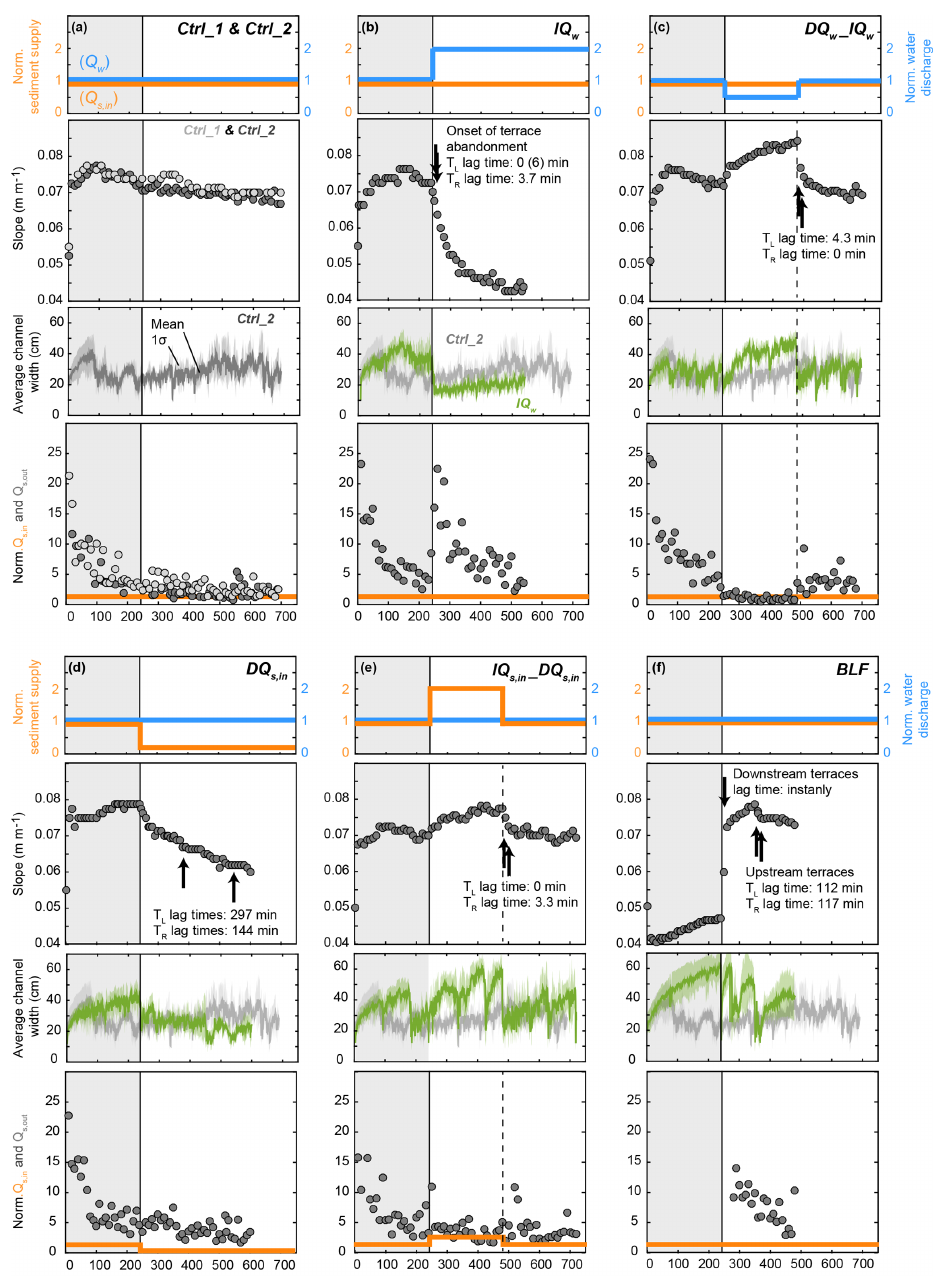
Figure 6. Input parameters and evolution of channel slope, channel width, and Q s , out during the experiments. Input sediment ( Q s , in , orange solid line) and water discharge ( Q w , blue solid line) were normalized to the reference input values ( Q s , ref = 1 . 3mLs − 1 and Q w , ref = 95mLs − 1 ). Slope ( S , grey circles) was calculated based on the bed-elevation difference between the inlet and the outlet divided by the length of the system. Channel elevation measurements for slope calculations were performed manually during the runs. Black arrows indicate times when terraces in the upstream part of the sandbox started to be cut. Channel width was calculated as the mean number (solid lines) of wet pixels in each of 1200 cross section within the box indicated in Fig. 2b and d. The colored shaded areas around the curves indicate the standard deviation of the 1200 measurements. The evolution of width without any external perturbation (Ctrl_2) is plotted for comparison with each other experiment in which external conditions were changed (b–f) . Note that no measurements are available for the Ctrl_1 experiment due to issues with the installation of the overhead camera. Sediment discharge at the outlet ( Q s , out , grey circles) during the experimental runs is compared to input sediment ( Q s , in , orange solid line); both were normalized to reference input values ( Q s , ref = 1 . 3mLs − 1 ). Note that no Q s , out measurements are available for the first 280min of the BLF experiment, as no sample collection was possible during the flooding of the surrounding basin during base-level regulations (Fig. 2a).The first 240min of each experiment was adjustment to the reference settings (grey box) and was not included in the